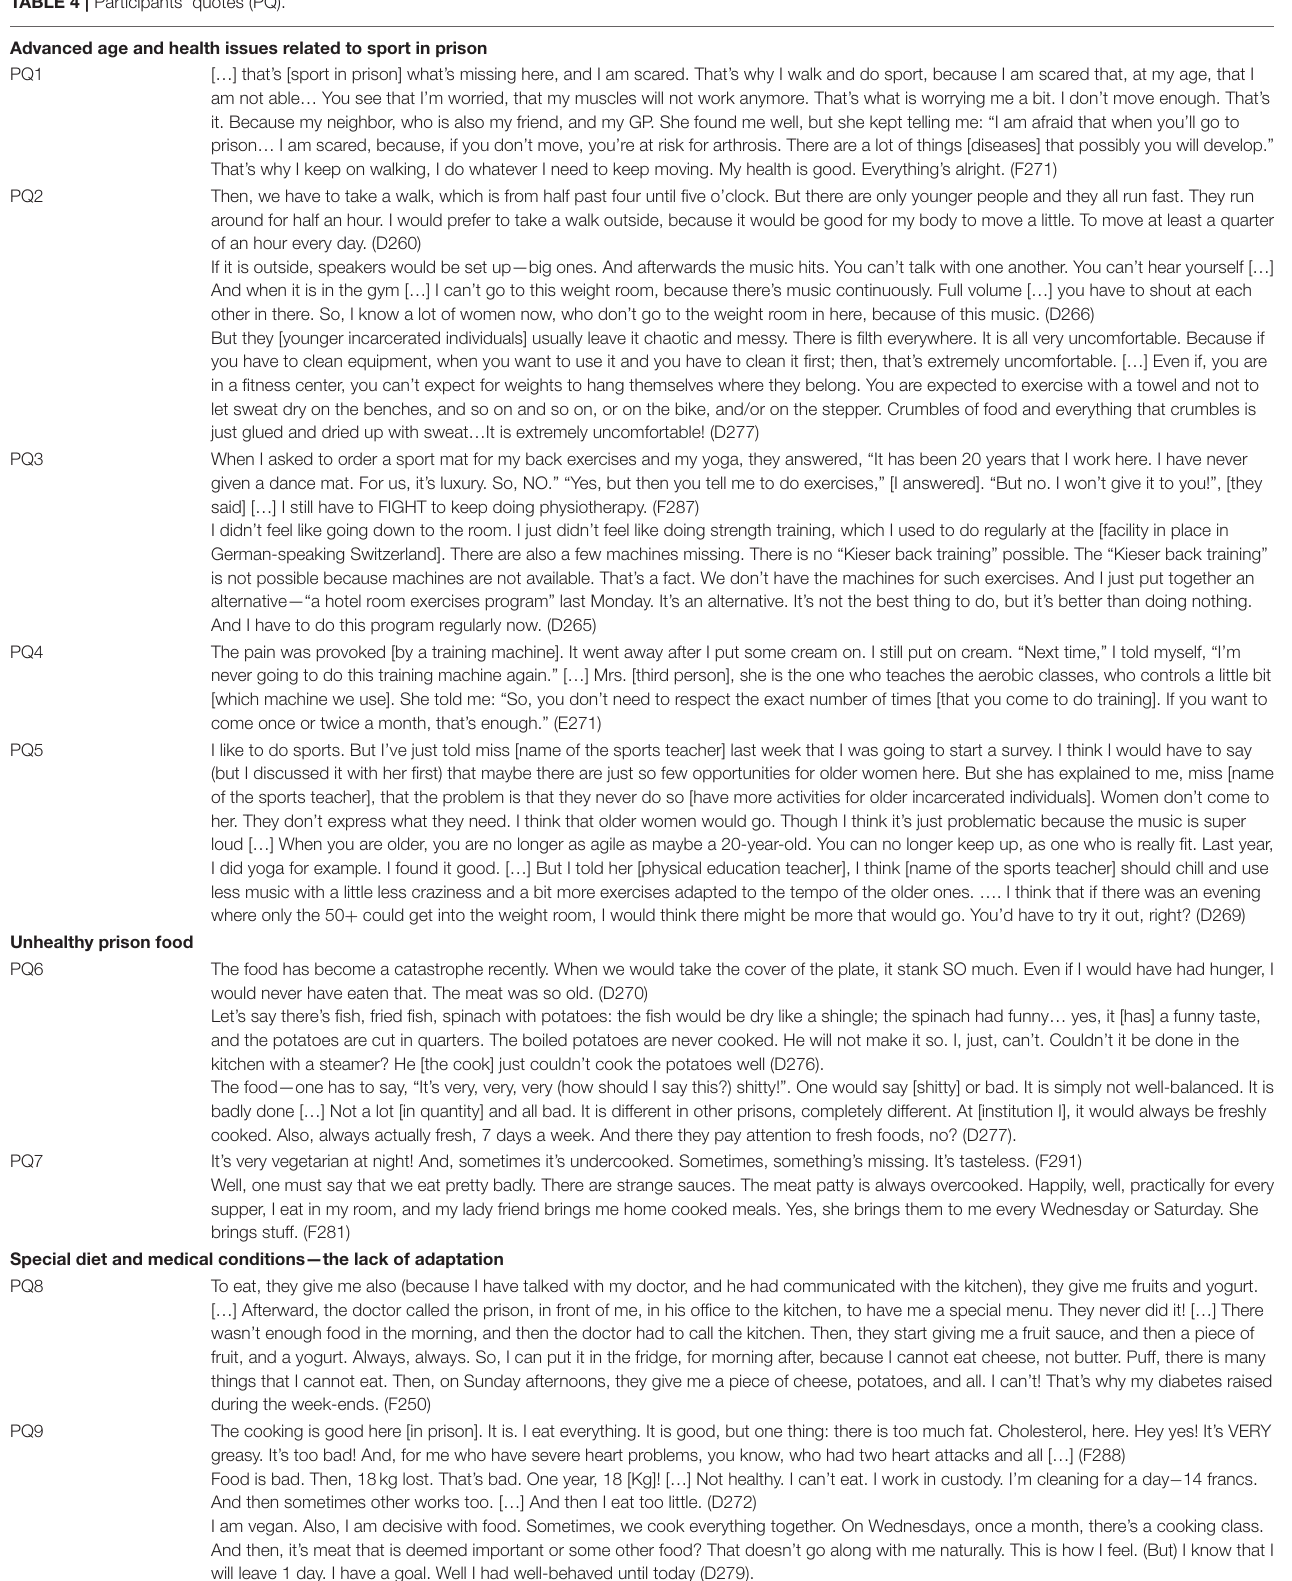
TABLE 4 | Participants’ quotes